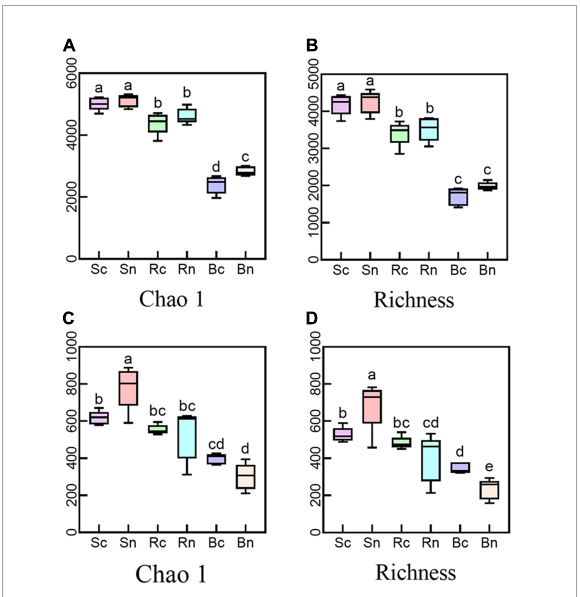
FIGURE1 Alpha diversity of the bacterial and fungal communities. Panels (A,B) representing alpha diversity of the bacterial community; (C,D) representing alpha diversity of the fungal community. Different letters ( P < 0.05) were considered to have Significances on the top. Sc, continuous cropping bulk soil; Sn, non-continuous cropping bulk soil; Rc, continuous cropping rhizosphere soil; Rn, non-continuous cropping rhizosphere soil; Bc, continuous cropping sugar beet root; Bn, non-continuous cropping sugar